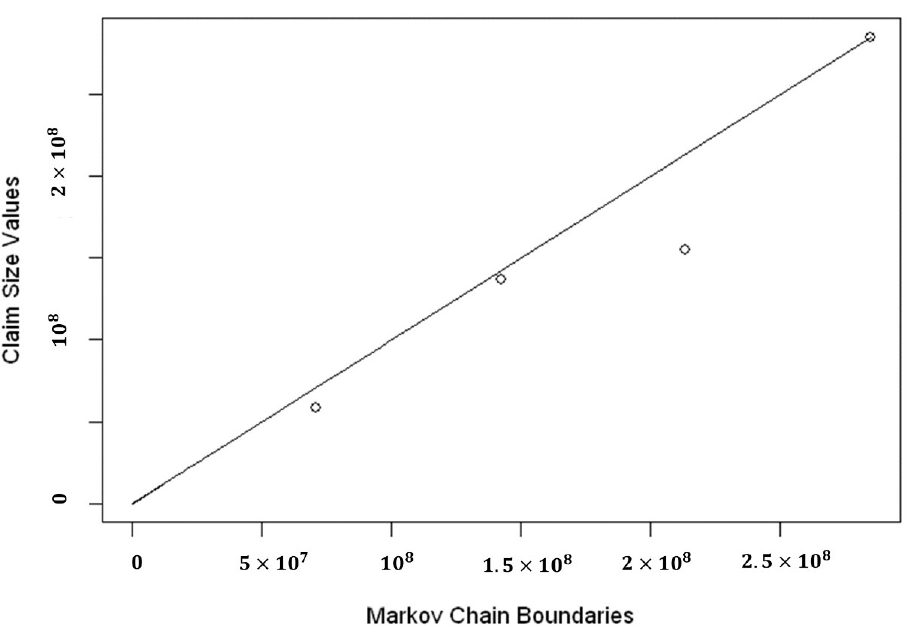
Figure 14. QQ-plot of Markov Chain claim boundaries and empirical claims in the boundaries for Group